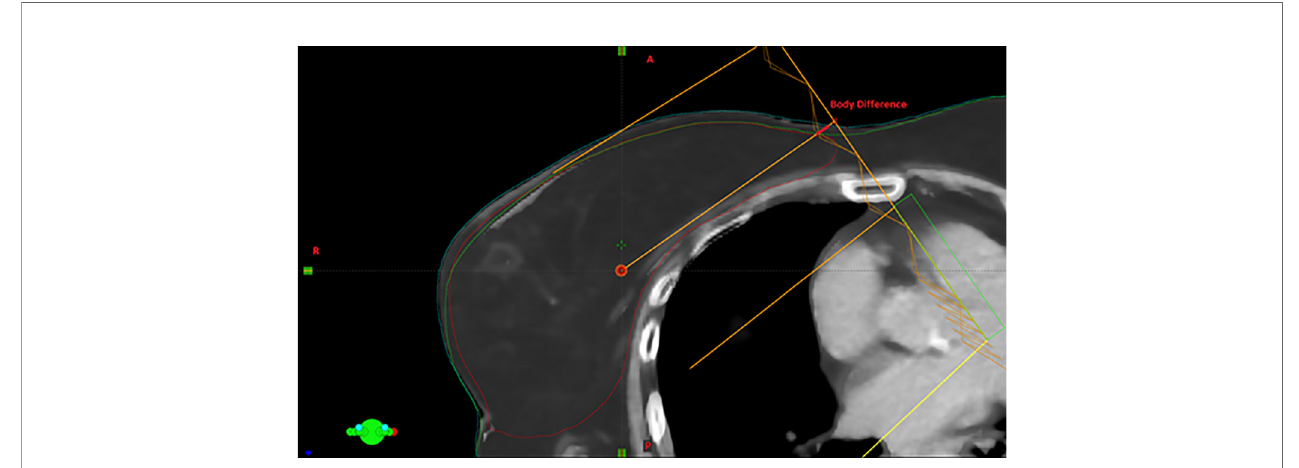
FIGURE 1 | Visual example of the body variation measurement: the difference between the body in CBCT and the corresponding one in simulation CT along the beam axis with higher MUs is highlighted in